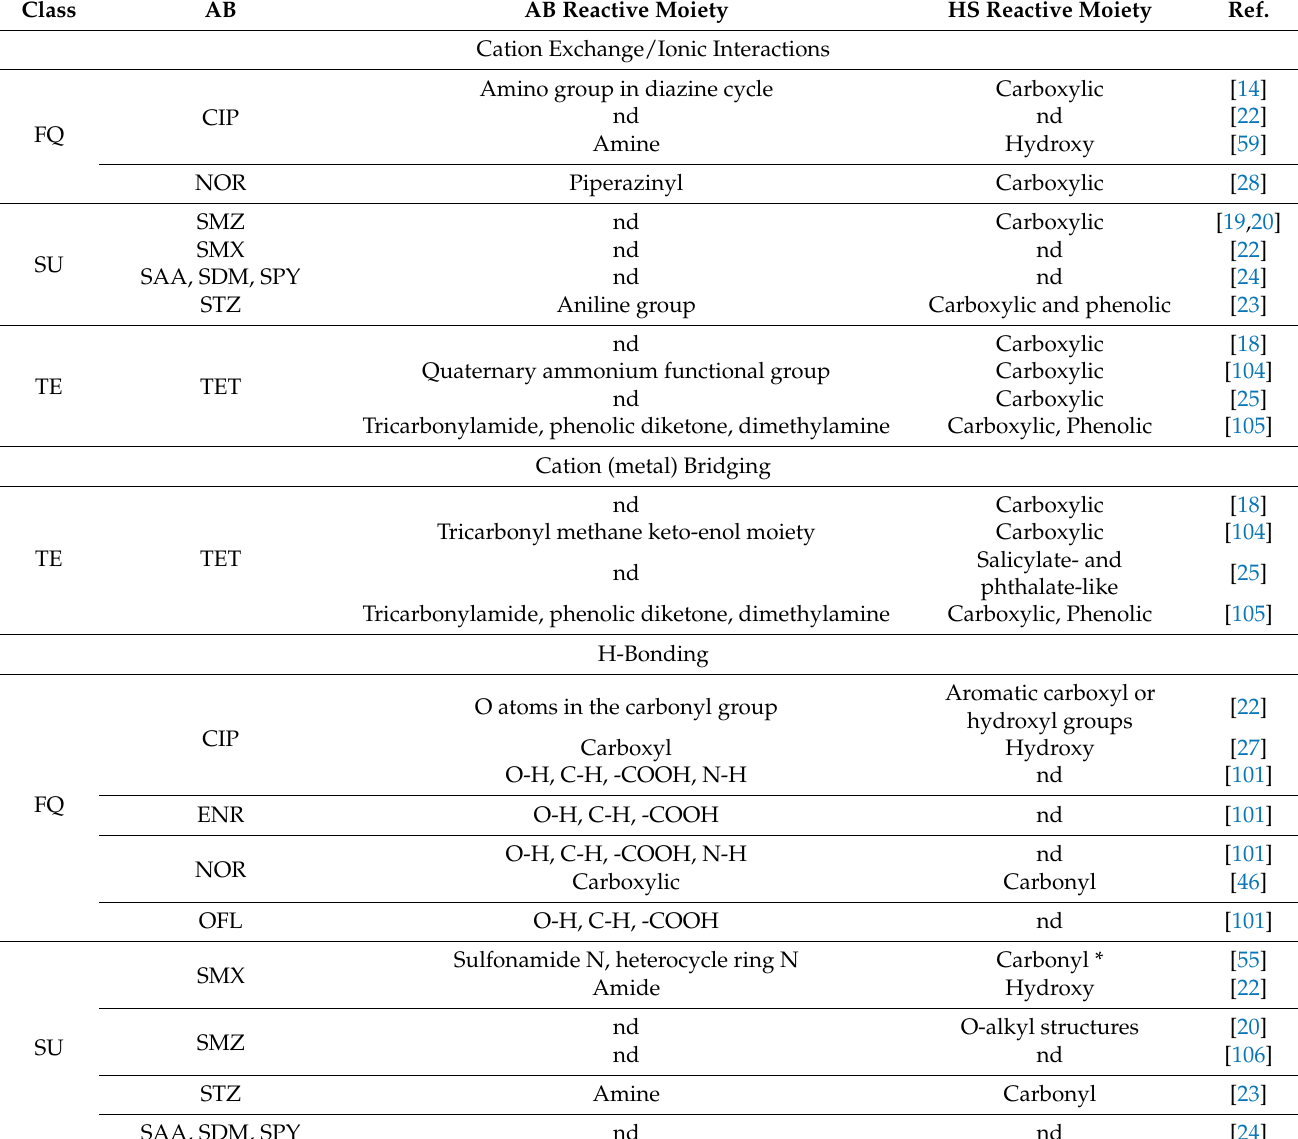
Table 5. The main proposed mechanisms of HS and NOM interaction with antibiotics of different